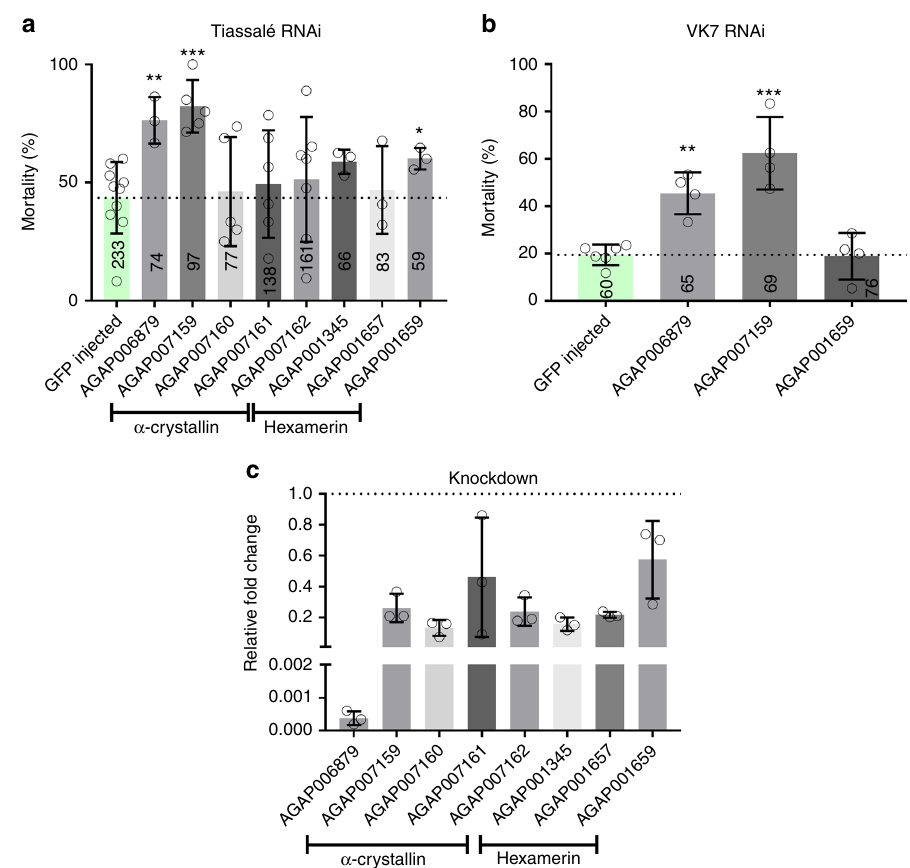
Fig. 3 RNAi phenotyping for potential candidates. RNAi was performed using two pyrethroid resistant colonies, Tiassalé and VK7. 3 – 5 day old females mosquitoes were injected with dsRNA from each of the respective transcripts. 72-h post injection, the mosquitoes were exposed to 0.05% WHO deltamethrin papers for 1 h and mortality scored 24 h later. a Mortality associated with dsRNA induced knockdown in Tiassalé mosquitoes. b dsRNAs showing signi fi cantly increased mortality in Tiassalé mosquitoes were then injected into a second resistant colony, VK7. c Knockdown levels for each dsRNA construct relative to GFP-injected controls (Tiassalé population only). Error bars represent standard deviation, three biological replicates and three technical replicates were used for each gene with each circle representing the mean value for each biological replicate in the qPCR data and signi fi cance is indicated by * p ≤ 0.05, ** p ≤ 0.01, *** p ≤ 0.001, as computed by ANOVA with post hoc Tukey correction. Numbers on the bars represent number